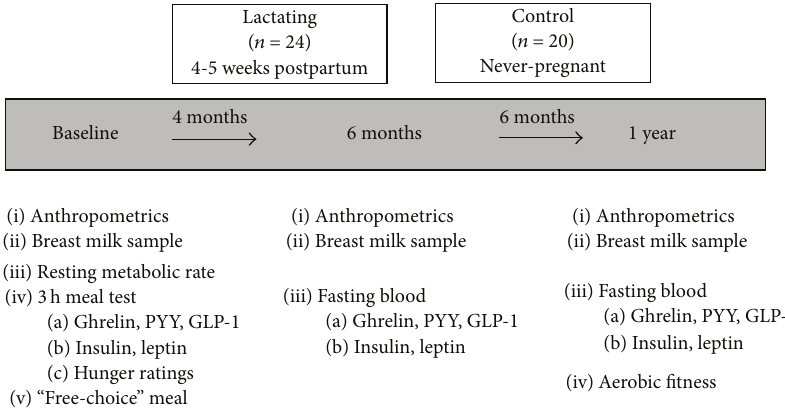
Figure 1: Schematic representation of the cross-sectional and longitudinal experimental